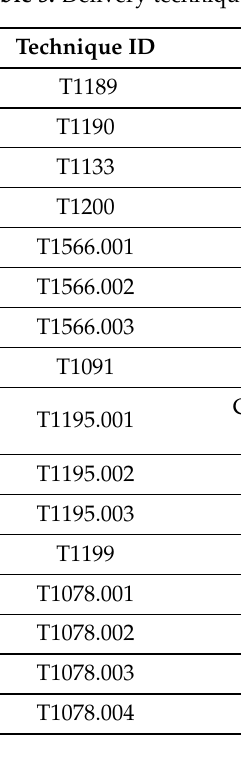
Table 5. Delivery techniques exploited by threat